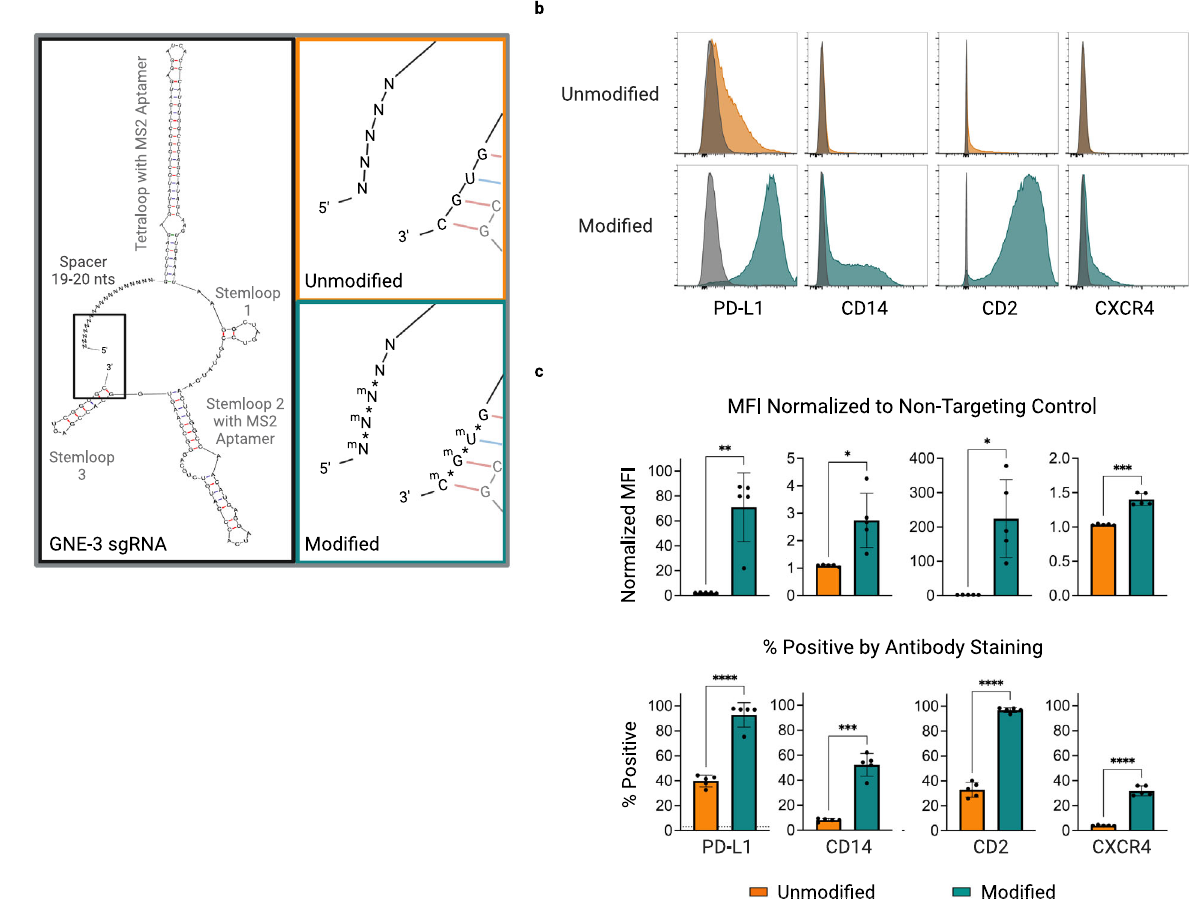
Fig.4|Chemicalmodi fi cationofsyntheticGNE-3sgRNAsenhancestargetgene activation.a StructuraldiagramofafullsgRNAwithGNE-3scaffoldhighlighting5 ′ / 3 ′ ends (black box). Magni fi ed view of sgRNA 5 ′ /3 ′ end regions highlighting unmodi fi ed(orange)ormodi fi ed(teal)nucleotides.Modi fi edsgRNAscontain2 ′ -O- methyl (m)/ phosphorothioate (*) linker modi fi cations. b , c Assessment of CRISPR mediatedgeneactivationbyunmodi fi edormodi fi edsgRNAsinaCAG-CRISPRa-sel engineered K562 population and assessed 3 days post-sgRNA delivery. b Gene expression displayed by representative fl ow cytometry histograms in populations electroporated with unmodi fi ed (top row, orange) or modi fi ed (bottom row, teal) GNE-3 sgRNAs. Stained cells electroporated with a non-targeting synthetic sgRNA